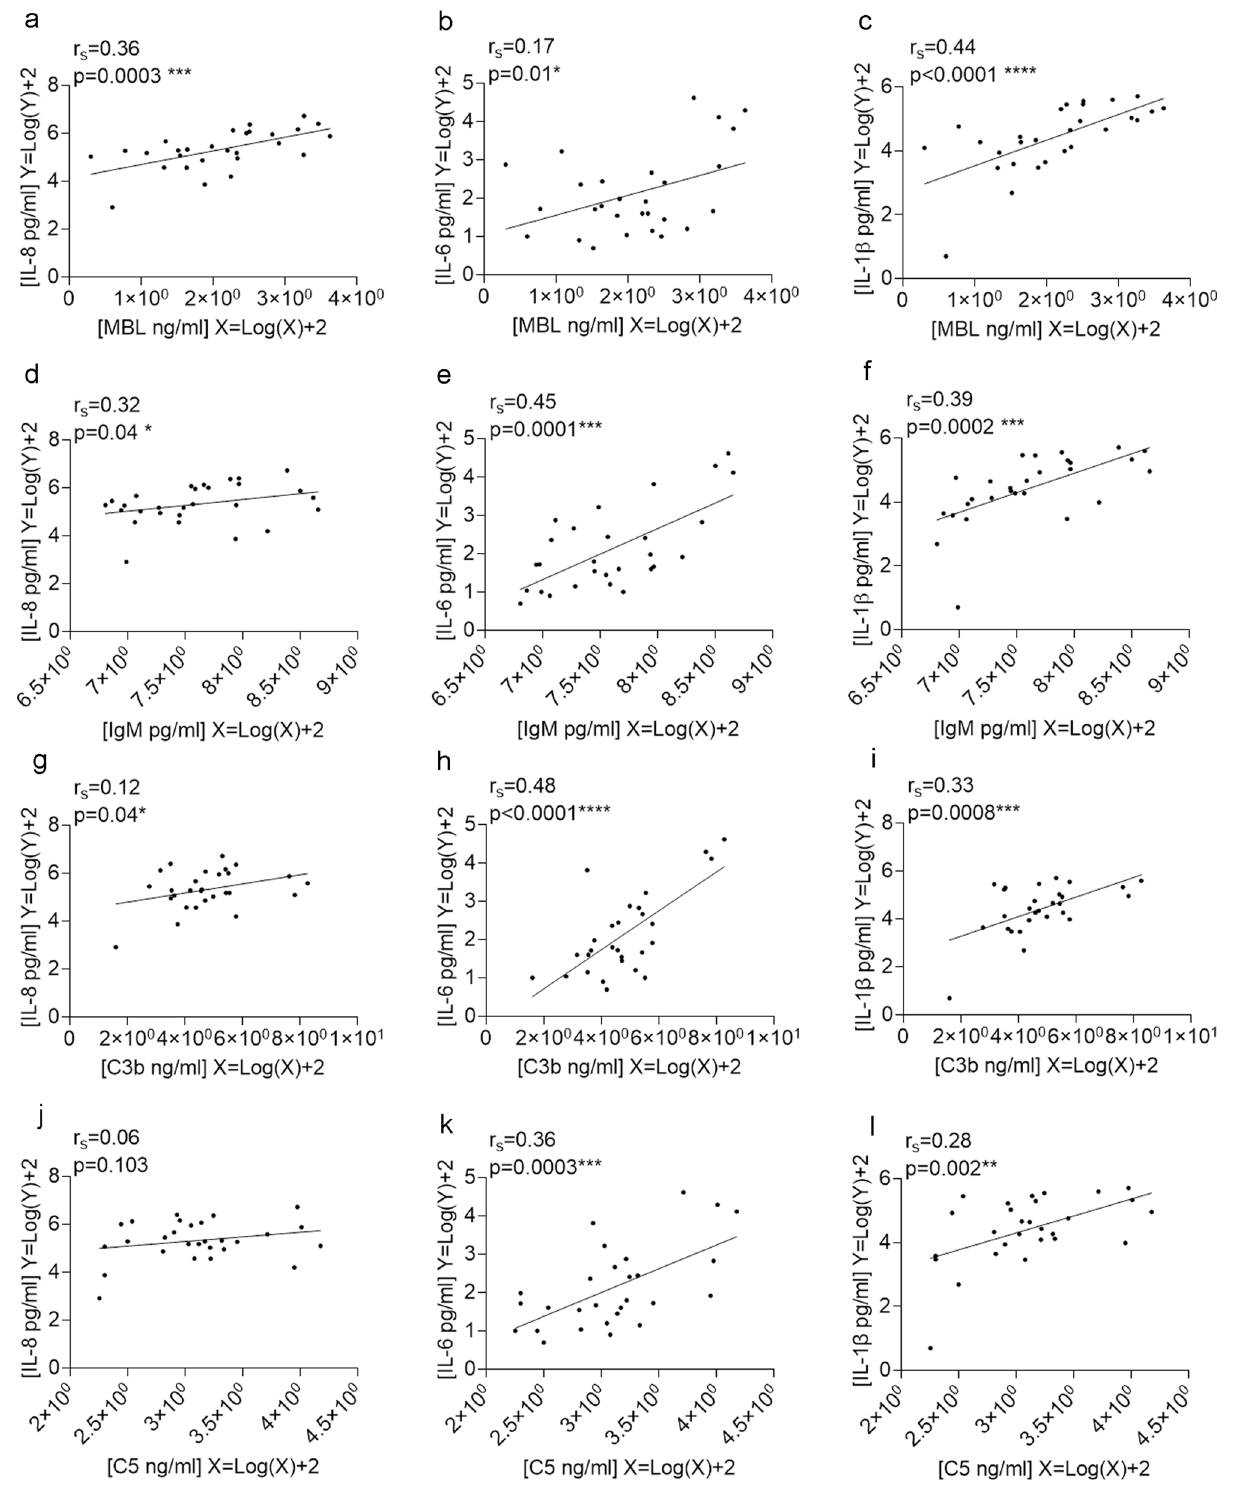
Fig. 6 Cervicovaginal IgM and complement positively correlate with pro-in fl ammatory cytokines in women who are lactobacillus deplete and who deliver preterm. In women who are Lactobacillus deplete and who deliver preterm a positive correlation was seen between cervicovaginal complement and cytokines. Concentrations were log transformed and a one-sided Spearman ’ s correlation was performed between; MBL and IL-8 ( a ). IL-6 ( b ), IL-1 β ( c ); IgM and IL-8 ( d ). IL-6 ( e ), IL-1 β ( f ); C3b and IL-8 ( g ), IL-6 ( h ), IL-1 β ( I ); C5 and IL-8 ( j ), IL-6 ( k ), IL-1 β ( l ). n = 28 samples. Source data are provided as a Source Data fi